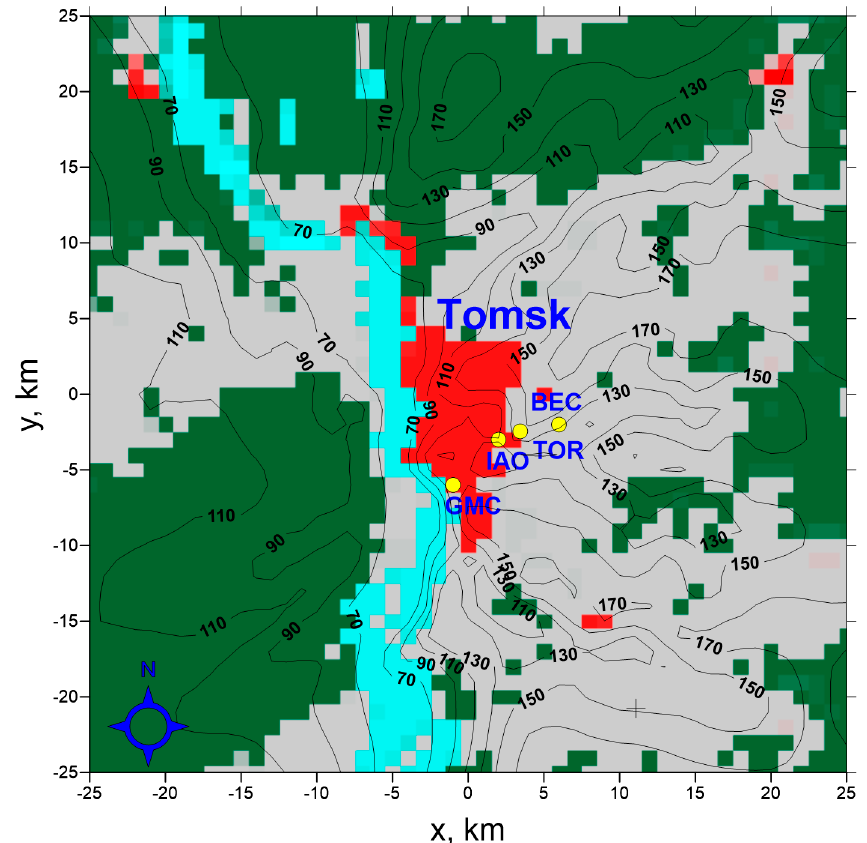
Figure 1. Terrain of the computational domain with the location of the observation sites (yellow dots), water (blue), shrub or grassland (light gray), forest (green), and urbanized areas (red). Contour lines represent terrain height (in meters) above sea level. The extent of computational domain is given in km.